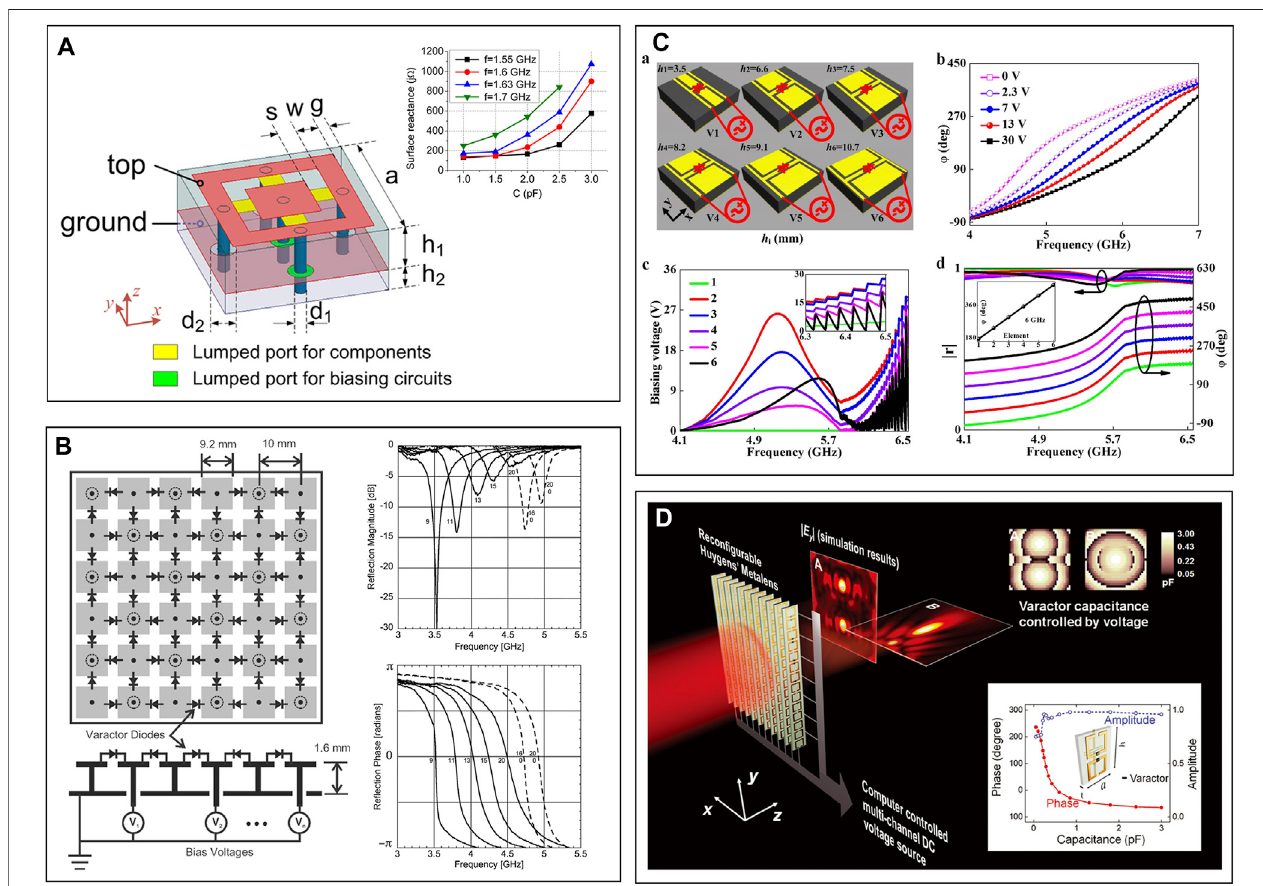
FIGURE 2 | (A) Electrically tunable metasurface absorber with embedded varactors. Reproduced from Luo et al. (2016) with permission from AIP Publishing. (B) Active metasurface with full 360 ° re fl ection phase tuning. Reproduced from Zhu et al. (2013) with permission from Spring Nature. (C) Tunable microwave metasurfaces with dynamical switch. Reproduced from Xu et al. (2016b) with permission from Spring Nature. (D) Recon fi gurable Huygens ’ metalens. Reproduced from Chen et al. (2017) with permission from John Wiley and Sons.